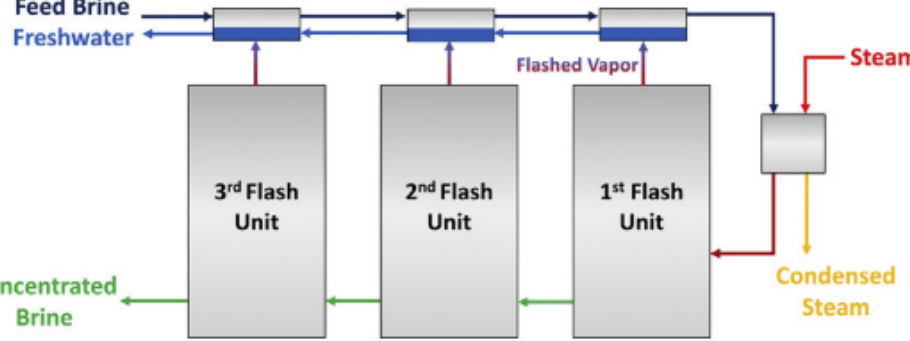
Figure 1. Schematics for multistage flash distillation (MSF). Extracted from Panagopoulos et al., 2019 [62].